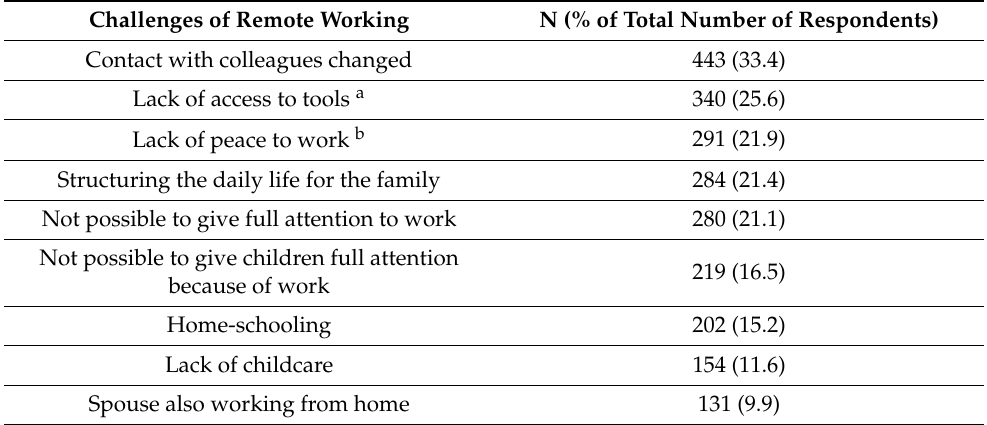
Table 5. Challenges of remote working during lock-down among respondents in the anonymously completed self-report survey in the Faroe Islands conducted from 13 April until 4 May 2020, n =